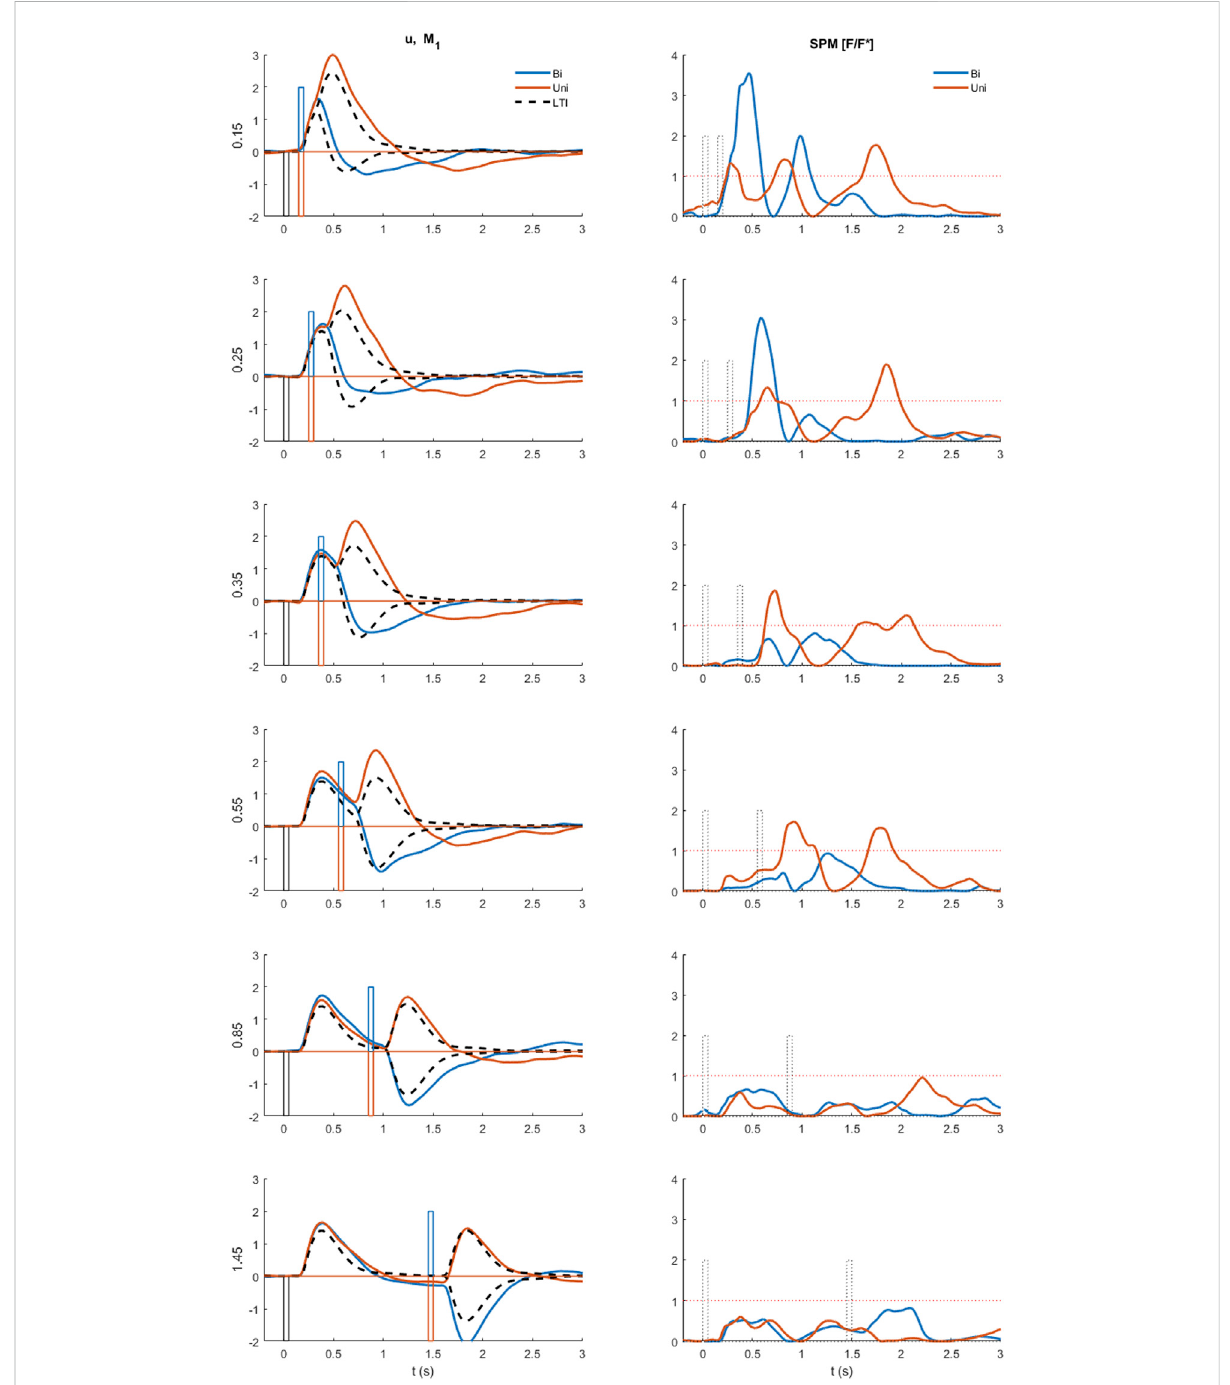
Comparison ofexperimentalcontrol signal uwithLTIprediction. Left:Experimental myoelectriccontrolsignal (u)for Bidirection(blue) andUni directional (red) paired stimuli. Single process, LTI Model M1 (dashed black). Impulse Stimuli (rectangular lines). All signals averaged over all cases for each subject, and then averaged over all subjects. N.B. For all positive fi rst stimuli, all signals reversed to align to negative fi rst stimulus and positive fi rstresponse.Right:TimevaryingFstatisticrelativetounitythreshold (F/F*atalpha0.05)forBidirectional(blue)andUnidirectional(red)paired stimuli. (1-dSPM, repeatedmeasures Anova, n =22).ImpulseStimuli (rectangular dotted lines), Message: At short ISI, theexperimental control signal shows substantial departure from LTI (M1)